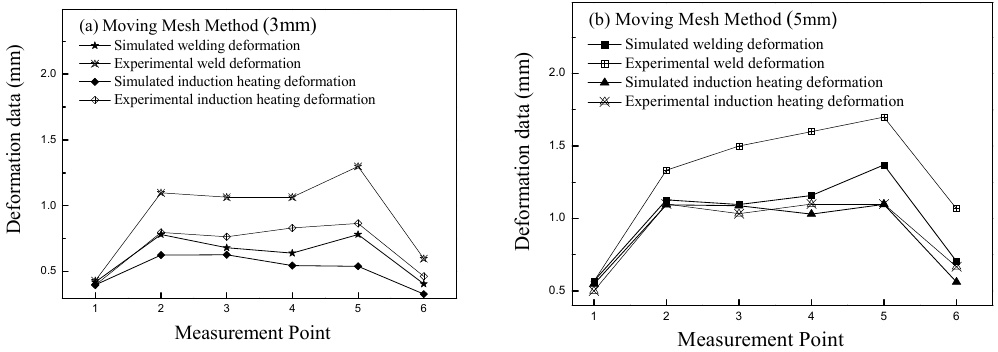
Figure 11. Temperature and deformation distribution obtained by the moving mesh method (5 mm).